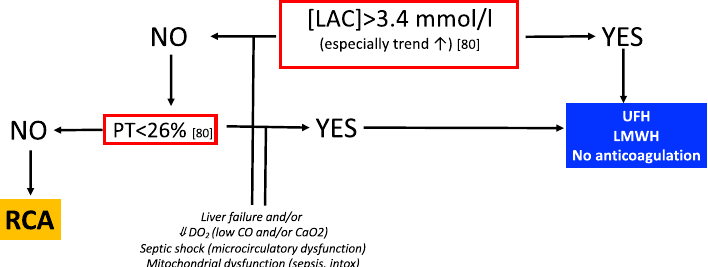
Fig. 3 Proposed algorithm for the selection of anticoagulation modality during RRT. Abbreviations: LAC, lactate concentration; PT, prothrombin time; UFH, unfractioned heparin; LMWH, low molecular weight heparin; RCA, regional citrate